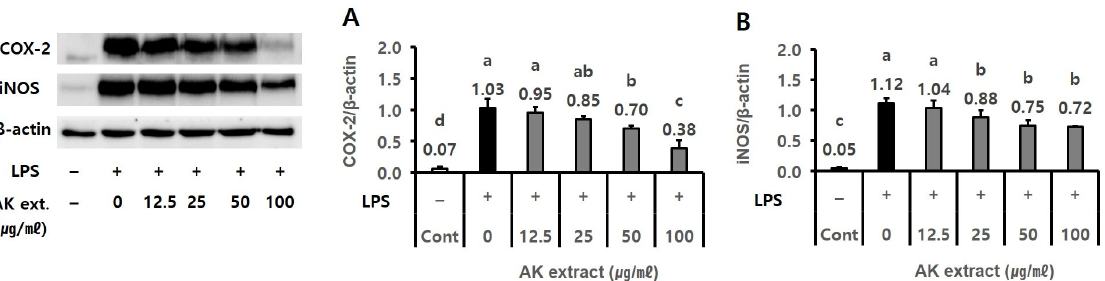
Figure 2. Effect of AK extract on the expression of ( A ) COX-2 and ( B ) iNOS in LPS-treated RAW 264.7 cells. RAW 264.7 cells (2 × 10 5 cells/mL) were treated with sample extracts for 2 h, and serum- free medium was used as the control. The plate was treated with 0.5 µg/mL LPS for 24 h ( n = 3 for Cox-2 and NOS). (–), LPS-untreated experiment; (+), LPS-treated experiment; LPS, lipopolysaccharide; Cont, control ( n = 3). Statistical analysis was performed using SAS software. The values indicated with different letters were found to differ significantly at p < 0.05 by Duncan’s multiple range